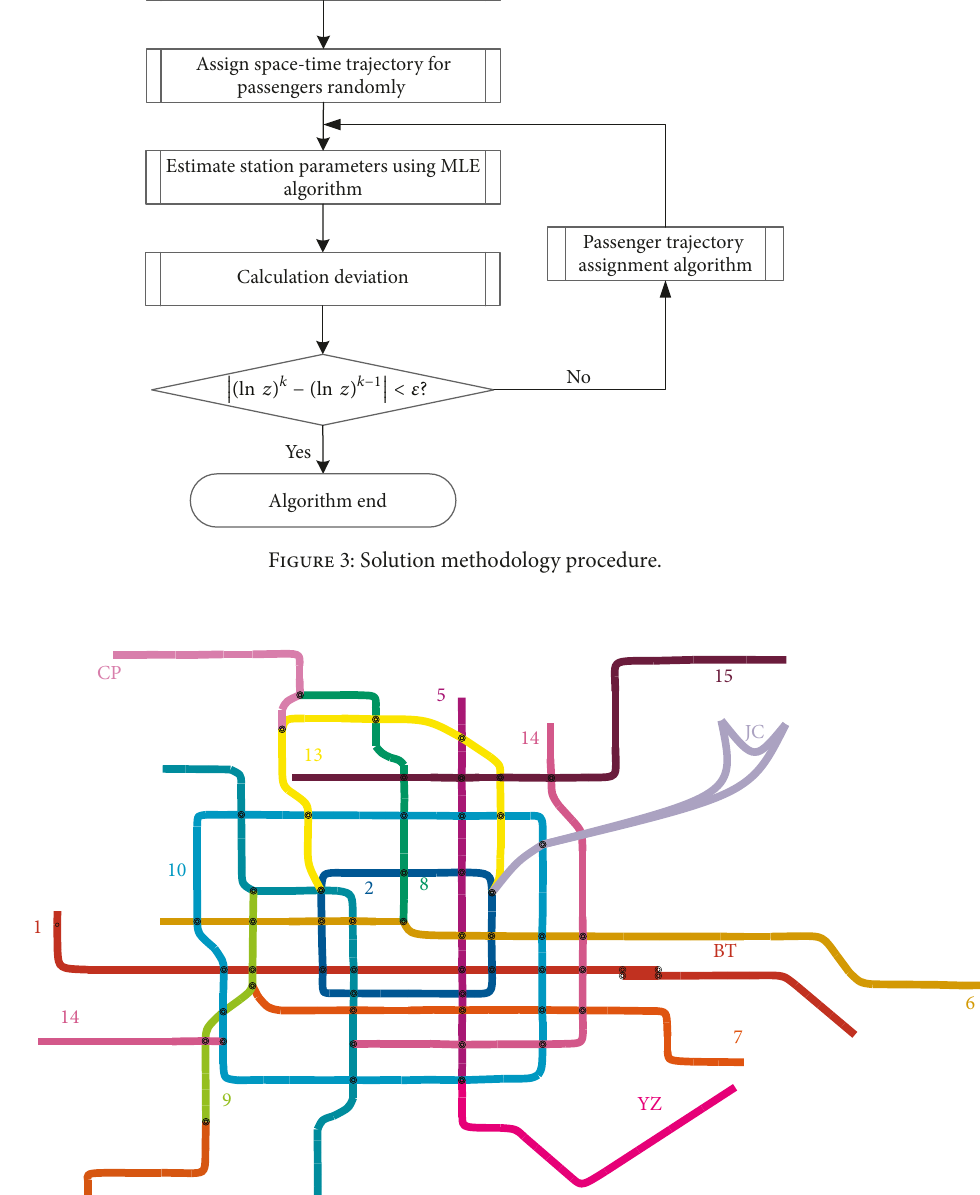
Figure 4: Topology of Beijing rail transit